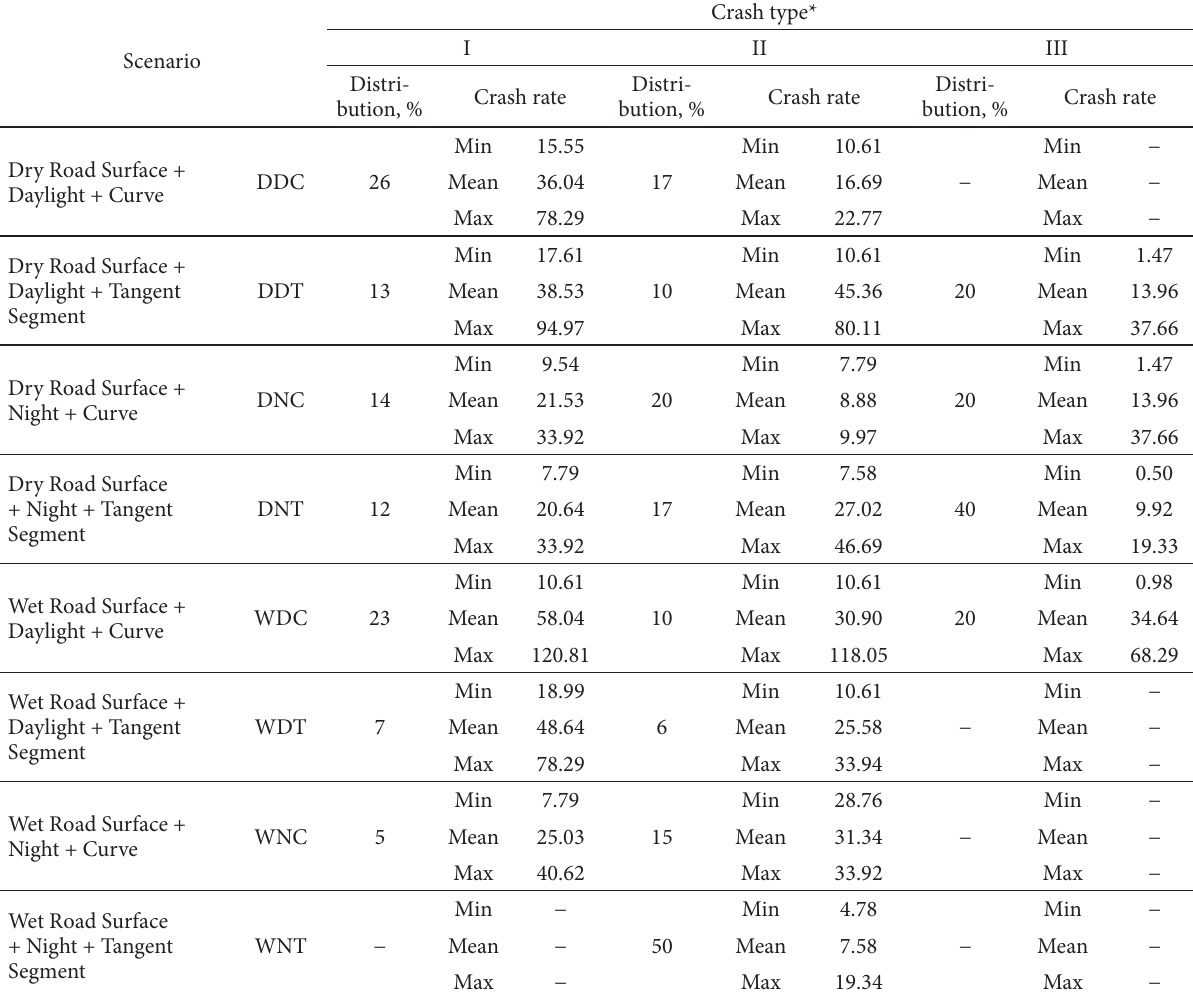
Table 1. Overview of the analyzed injury crashes in 2003 – 2010